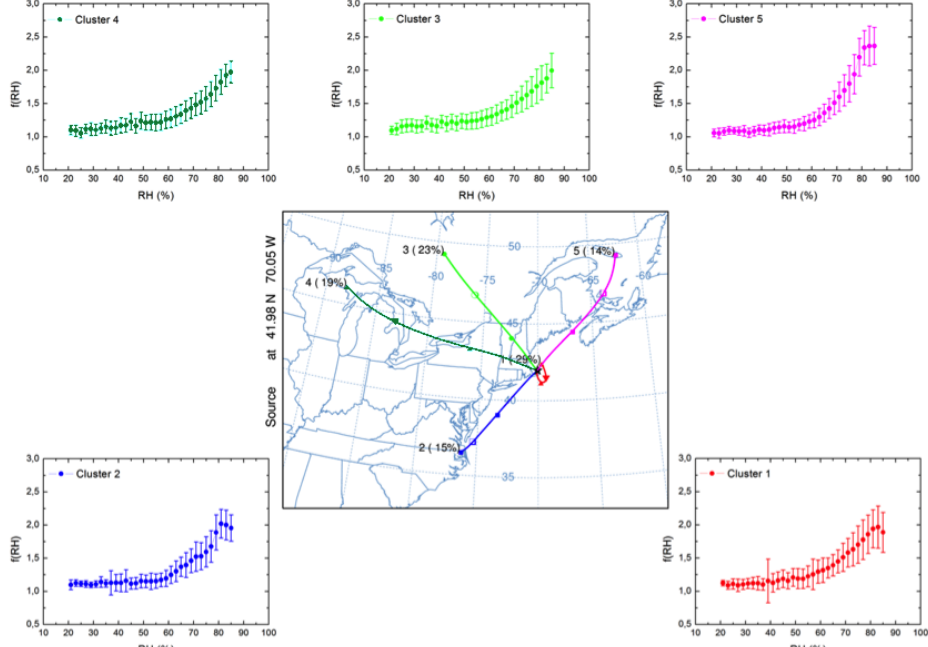
Figure 6. Clusterization of 3-day air-mass back trajectories arriving at Cape Cod at 500ma.g.l. at 00:00, 06:00, 12:00 and 18:00GMT according to the HYSPLIT4 model (central panel) and average humidograms for each cluster. The error bars denote the standard